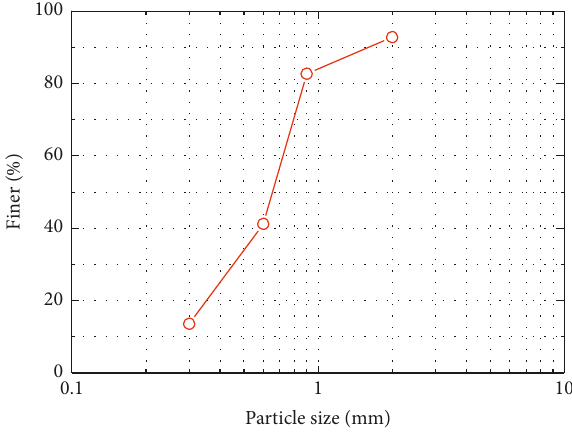
Figure 3: The size distribution curve of sand.